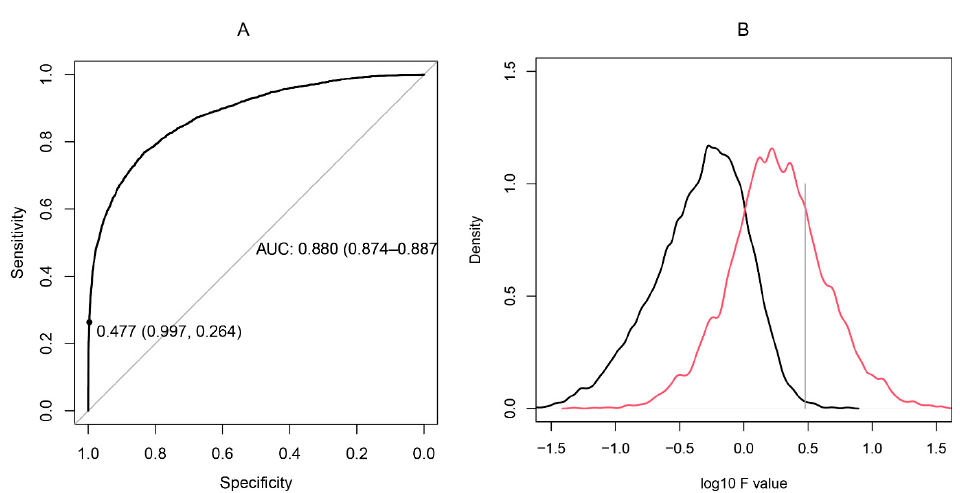
Figure 2. Illustration of cross-reactive ( A ) and dissimilar ( B ) peptide reactivities based on the stud- ied set of 21 patients.